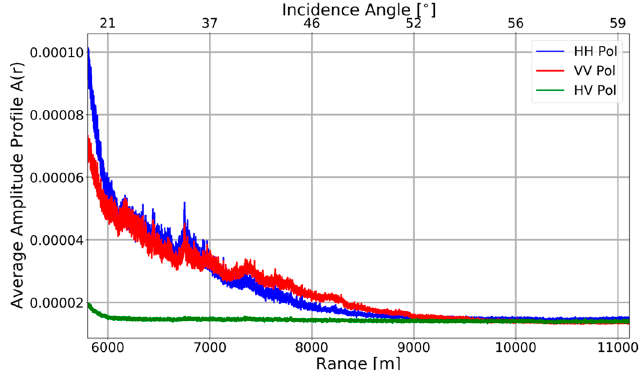
Figure 7. Amplitude over range profile of the sea backscatter in HH, VV and HV polarization channels of RC F-SAR X-band radar data.